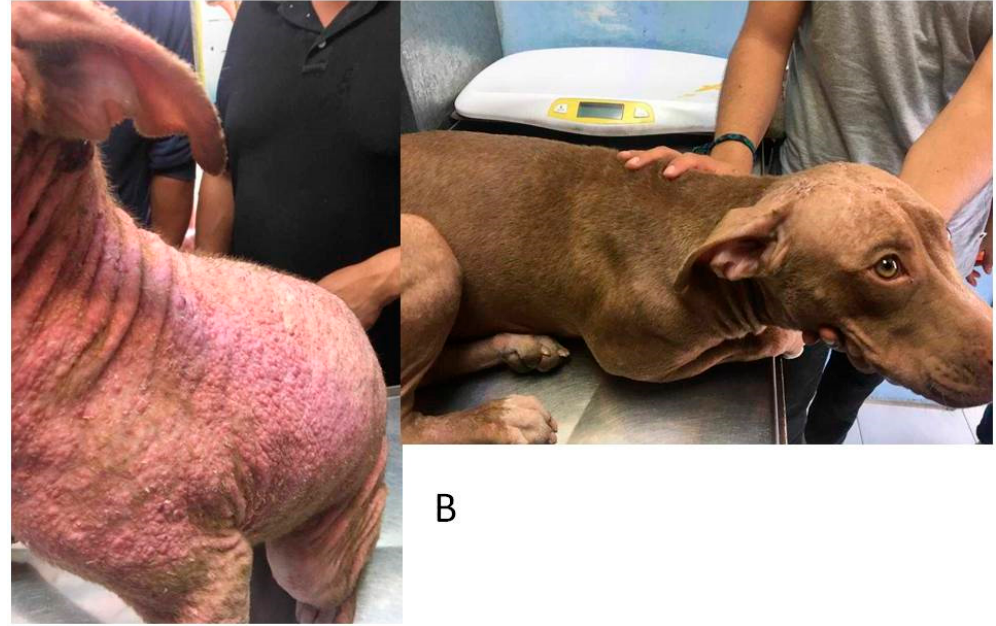
Figure 3. Canine unresponsive deep-pyoderma, classified as very severe, and treated with enrofloxacin HCl-2H 2 O (enro-C) at a dose of 10 mg / kg orally in gelatin capsules plus enro-C as gel, thrice a day. Aspects of the disease in a dog at admission ( A ) and 17 days later ( B ).